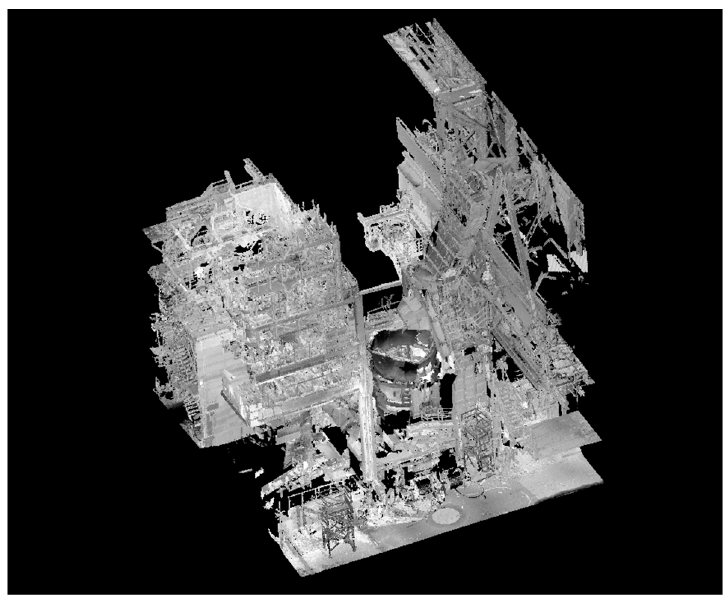
Figure 16. Point cloud of the plant that was scanned using a laser scanner (1.3 × 10 8 points).